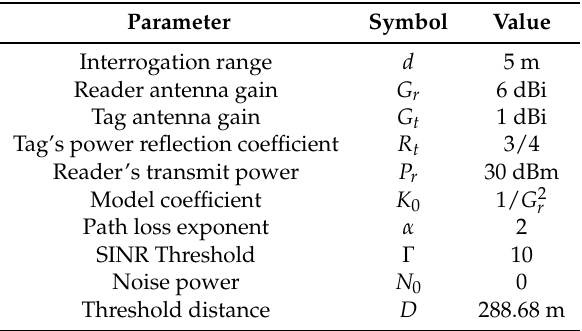
Table 1. Parameters of the interference